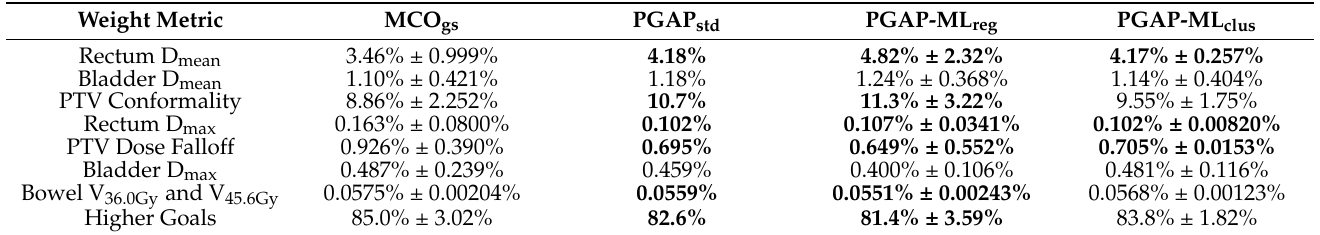
Table 8. Summary of PG relative weights. Values are mean averages across the the validation dataset ± one standard deviation. Boldface indicates statistically significant differences from MCO gs at the 95%